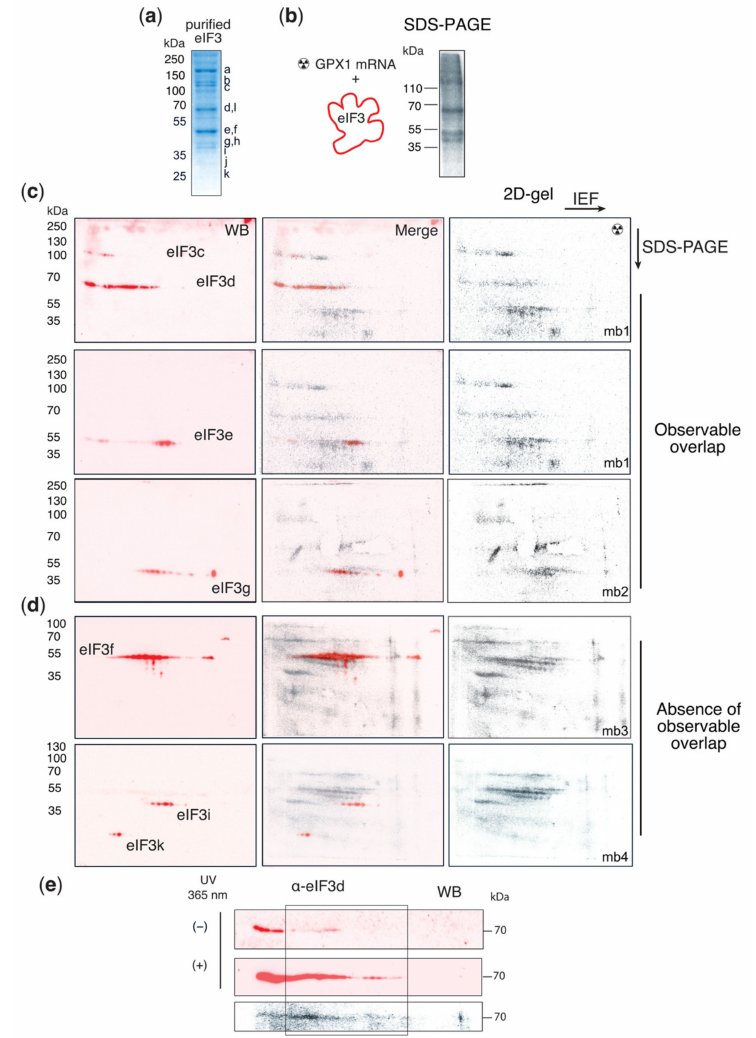
Figure 2. Identification of eIF3 subunits c, d, e, and g in interaction with GPX1 mRNA by UV crosslinking and Western blotting. ( a ) SDS-PAGE gel showing the purified eIF3 complex obtained from W.C Merrick [47]. The subunits are labeled according to their approximate mobilities. ( b ) UV crosslinking of [ α 32 P]-ATP radiolabeled thioU-GPx1 mRNA in the presence of purified eIF3 complex at 365 nm. After RNase A digestion, radioactive mRNA fragments protected against degradation remain cross-linked to eIF3 subunits. [ 32 P]-labeled proteins are resolved by SDS-PAGE ( b ) or 2D-gel electrophoresis ( c ). In the first dimension, proteins were separated by isoelectric focusing (IEF) pH 4–7 followed by SDS-PAGE in the second dimension. Radiolabeled proteins are transferred to PVDF membranes, revealed by Phosphorimaging ( b ). ( c , d ) Western blotting (WB) using antibodies directed against individual eIF3 subunits. Identification of cross-linked proteins by superimposition of WB signals (red signals, left panels) and radioactive signals (grey signal, left panels) are visible in the overlay (merge, middle panels). Three replicate experiments were performed. The PVDF membranes in panels ( c ) and ( d ) are products of four independent 2D gels. The PVDF membranes are numbered mb1–mb4. In panel ( c ), mb1 was probed successively with α -eIF3c, α -eIF3d and α -eIF3e, mb2 by α -eIF3g antibodies, the membrane mb3 of panel ( d ) with α -eIF3f, mb4 with α -eIF3i and α -eIF3k. The first 32 P panels (mb1) are therefore duplicate images. The position of the molecular weight markers is indicated. ( d ) No eIF3j signal was detected and therefore no superimposition was reported between eIF3j and GPx1. ( e ) Comparison of the migration profiles of eIF3d on 2D gel in the presence (+) and absence ( − ) of GPx1 mRNA crosslinking. The cross-link of eIF3d to GPx1 mRNA induces a shift of the WB signal to the boxed